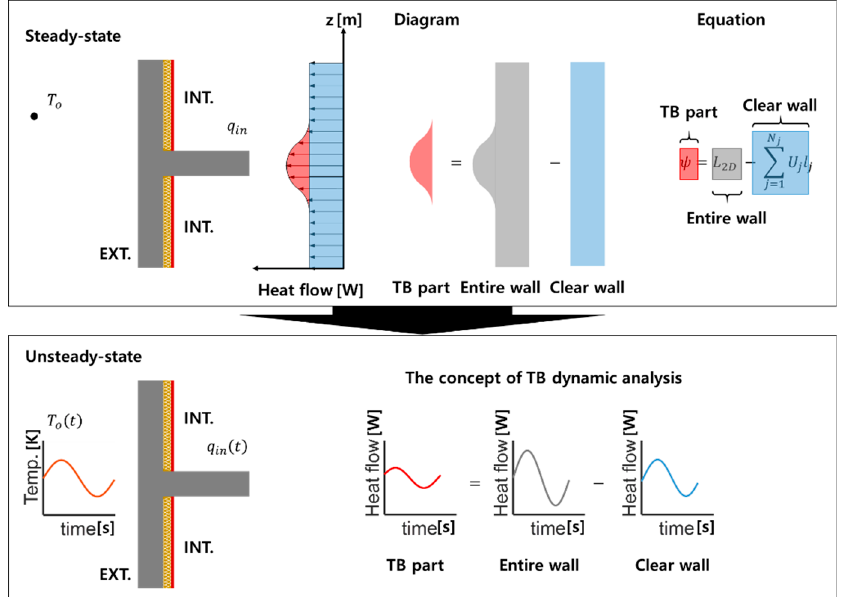
Figure 1. Concept for the analogy of a steady-state thermal bridge (TB) analysis. T o is the outdoor temperature and q in is the heat flow into the